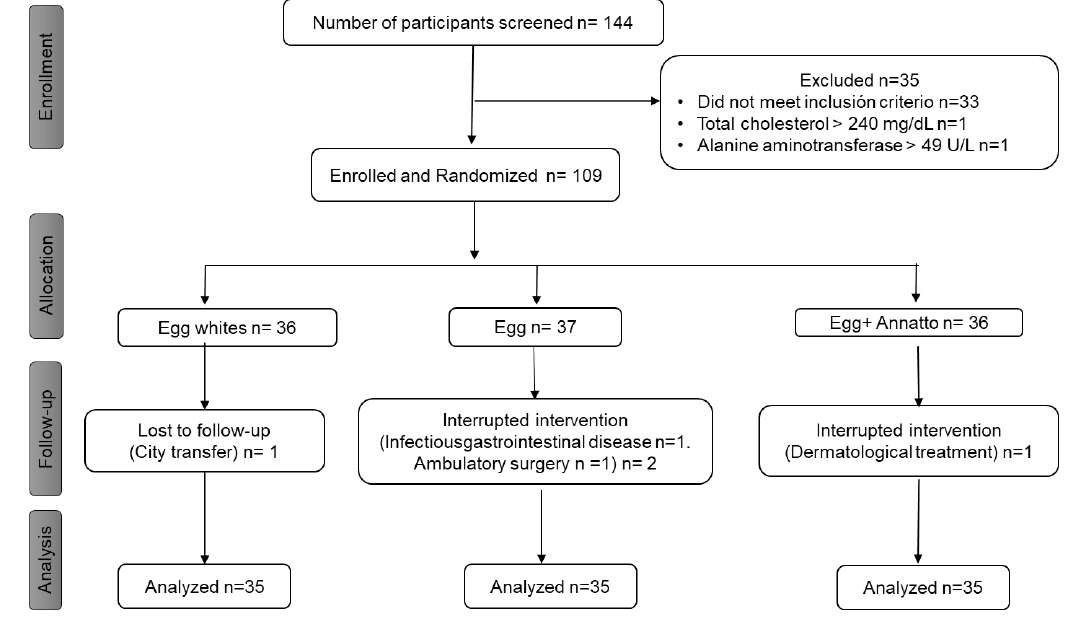
Figure 2. Study intervention flowchart. Table 1. Description of the study population according to the treatment groups.